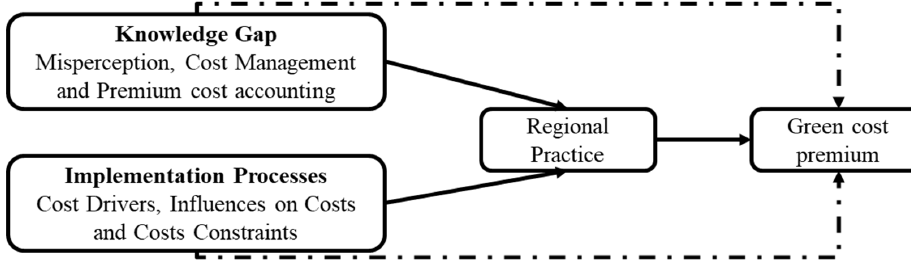
Fig. 4. Conceptual framework of the relationship between GCP and SB